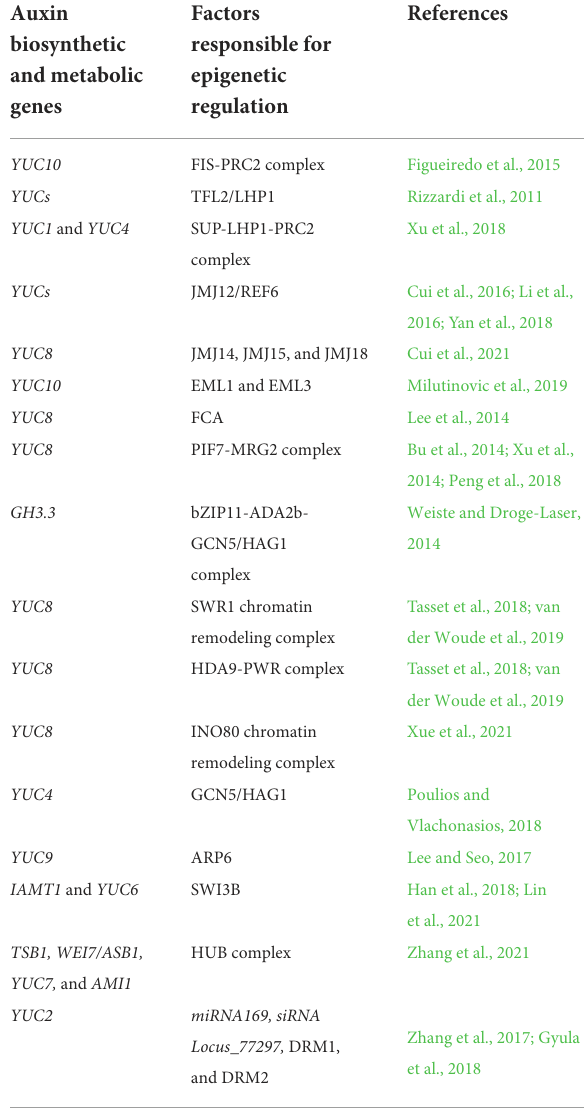
TABLE 1 Epigenetically regulated auxin biosynthetic genes and the factors involved in the epigenetic modification. Auxin